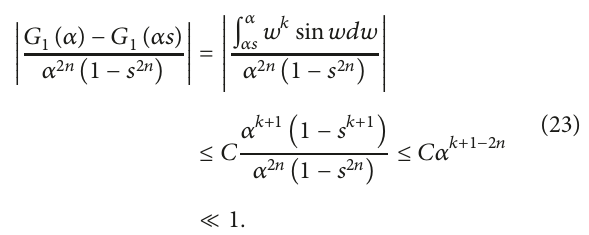
Figure 4: The graph of 𝜆(𝛼) for 𝑘 = 𝑛 = 2 .